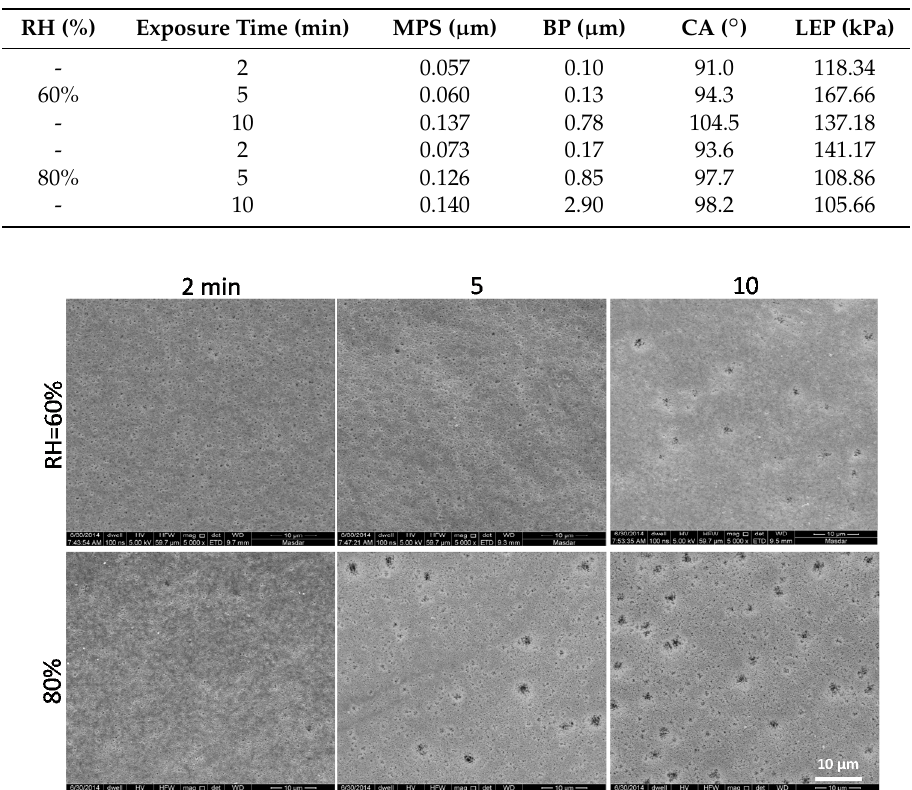
Table 4. Membranes properties with casting thickness of 500 µ m and PVDF concentration of 12% ( w / w ).